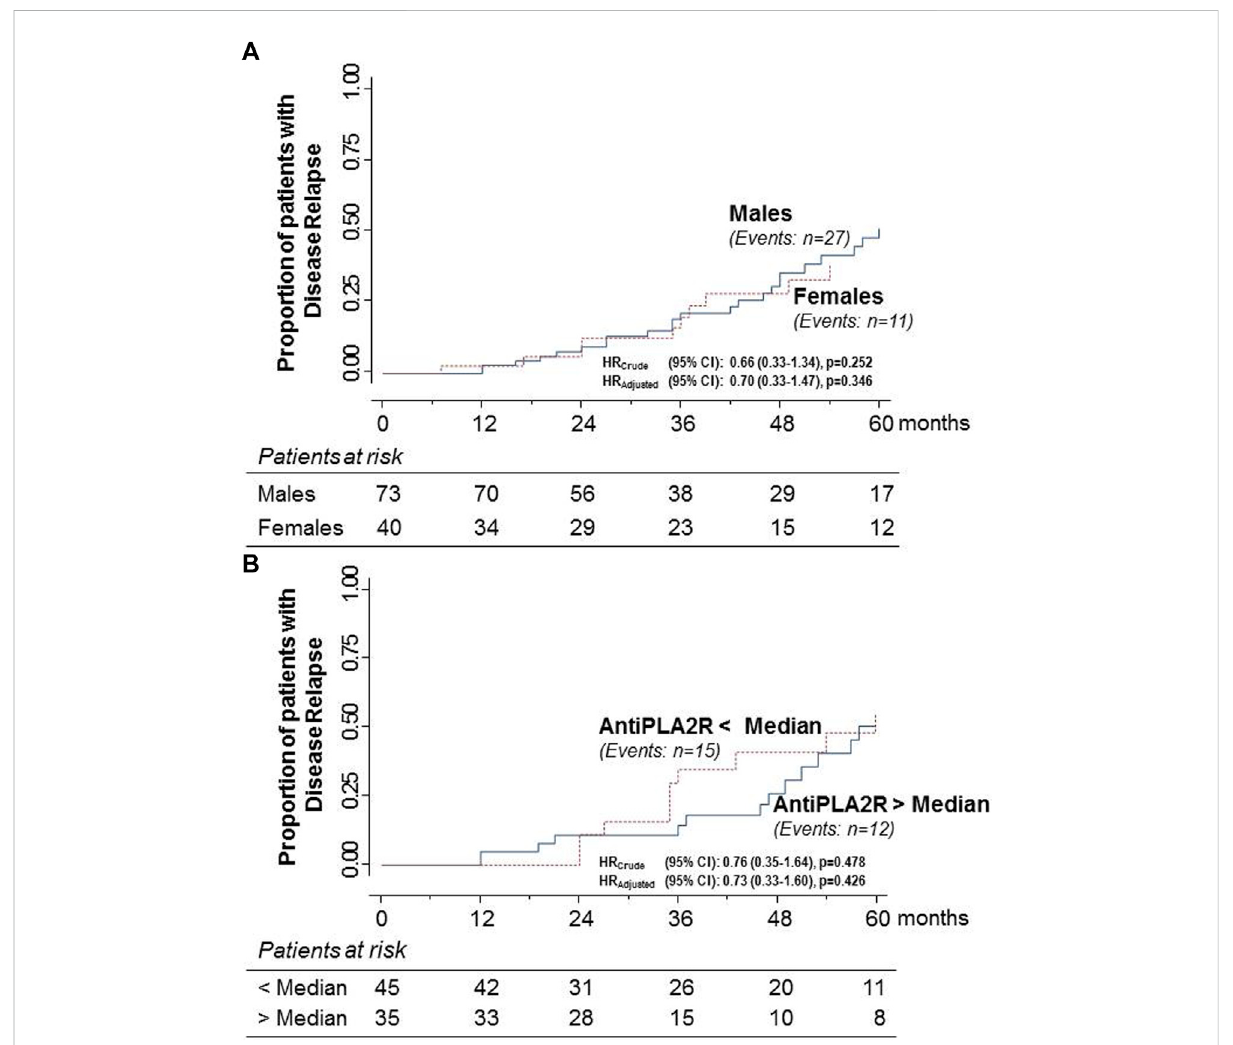
FIGURE 5 Kaplan – Meier curves for the proportion of participants with primary MN who had a relapse of the NS after progression to the combined endpoint of complete or partial remission in males and females (A) and in patients with anti-PLA 2 R antibody titer above or below the median (B) considered separately. Relapse rates never differed signi fi cantly between considered